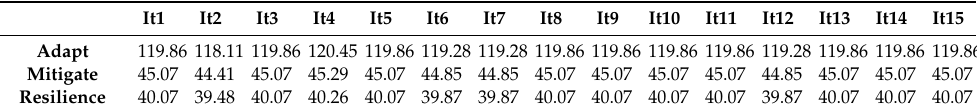
Table 5. Expected counts of data for